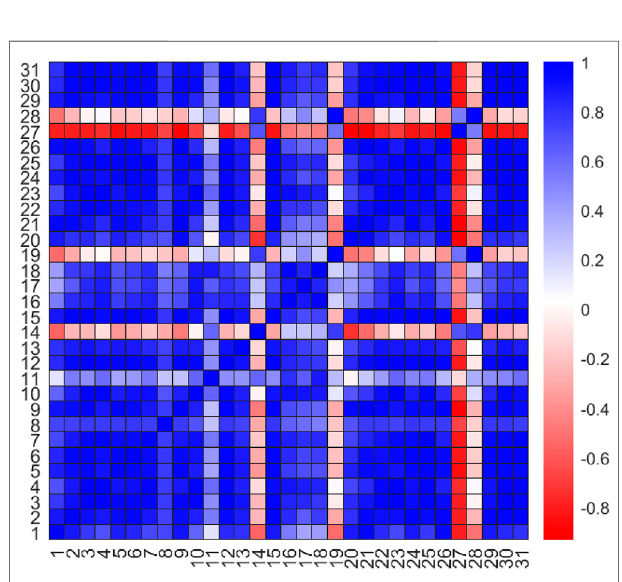
FIGURE 10 | Heat map of the similarity of